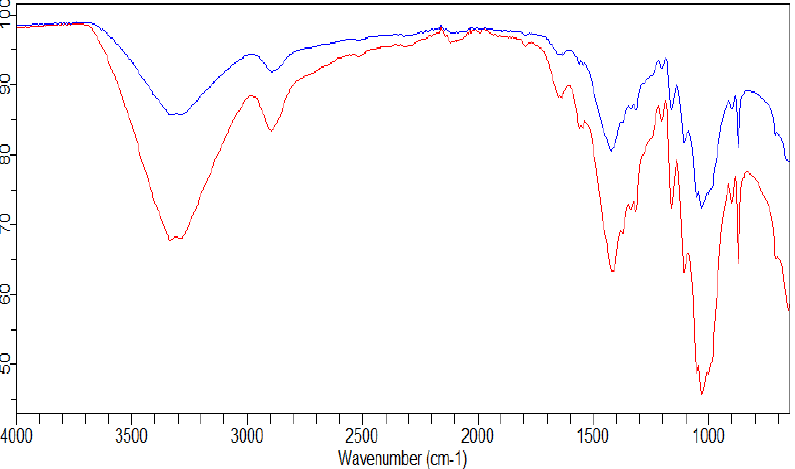
Figure 6. FT-IR spectrum showing the changes in the paper pulp during enzymatic treatment in the range of 4000–600 cm −1 . Beauveria bassiana SAN01 treated pulp ____ , Control pulp ____ .